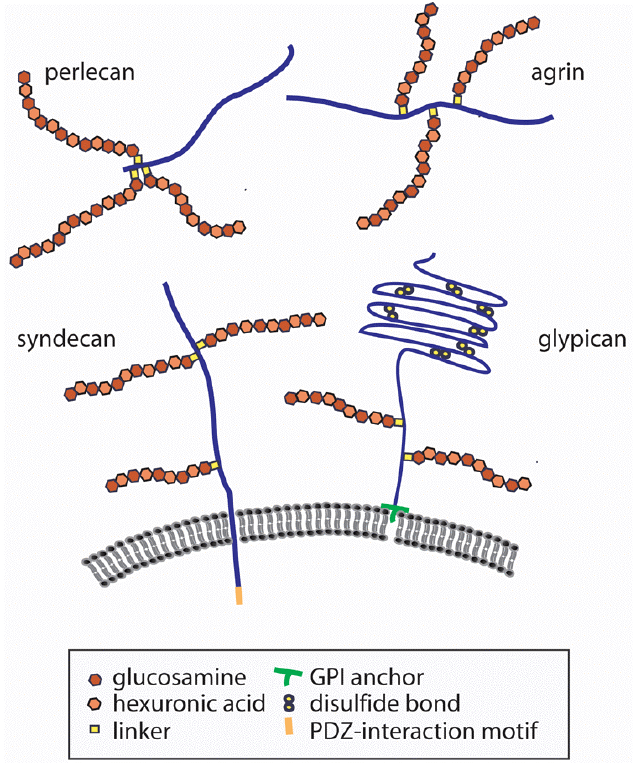
FIGURE 1. Cell surface and extracellular HSPGs. Syndecans and glypicans are integral membrane proteins. Syndecan is a single-pass transmembrane protein with a short conserved cytoplasmic domain containing a C-terminal PDZ-interacting motif. HS side chains are attached to the extracellular domain of the core protein at conserved Serine residues. Yellow boxes represent a typical tetrasaccharide linker region, which connects the HS chain to the serine. The glypican core protein forms a globular domain, which is stabilized by conserved disulfide bonds and linked to the cell surface via a GPI anchor. In contrast to syndecan, the major HS attachment sites in glypican are located proximal to the membrane. Perlecan and agrin are large multidomain proteins that contain several HS attachment sites. They both exist as multiple isoforms that are generated by alternative splicing and are found in basement membranes of many